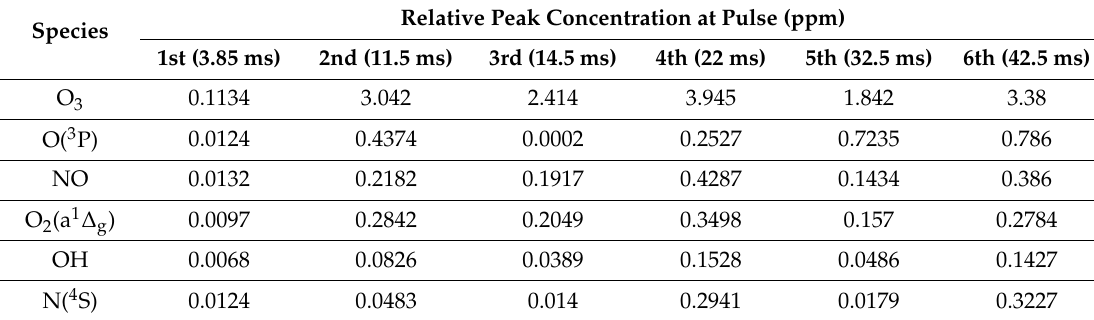
Table 2. Relative peak concentration of the most abundant species.